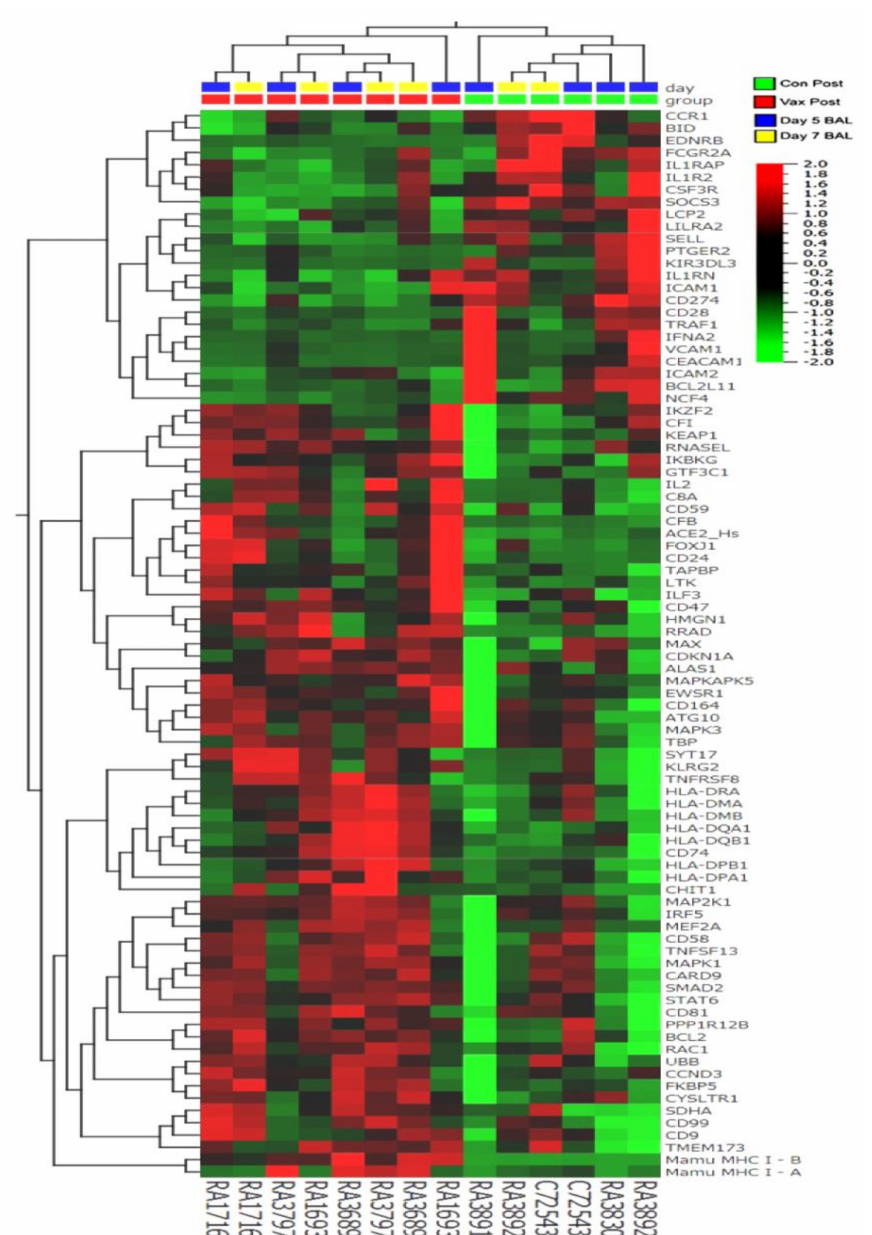
Figure 5. Hierarchical clustering of gene expression in BAL samples collected from control and vaccinated macaques five and seven days post-SARS-CoV-2 challenge. The heatmap shows signifi- cantly ( p < 0.05) upregulated (red) genes (63 genes > threefold) and downregulated (green) genes (24 genes < 1/3-fold) from a total of 730 genes analyzed using the NanoString Non-Human Pri- mate Immunology V2 Panel and identifies a set of genes possibly associated with protection from SARS-CoV-2